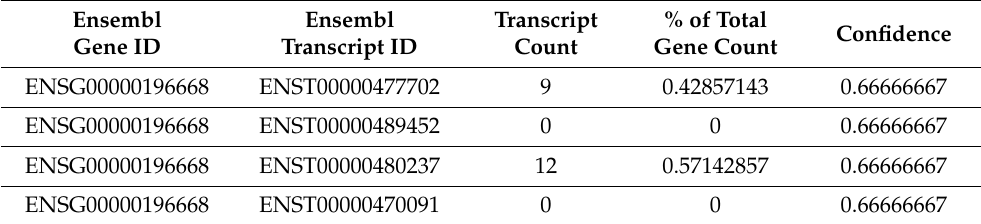
Table 3. Transcript counts for the use case generated by